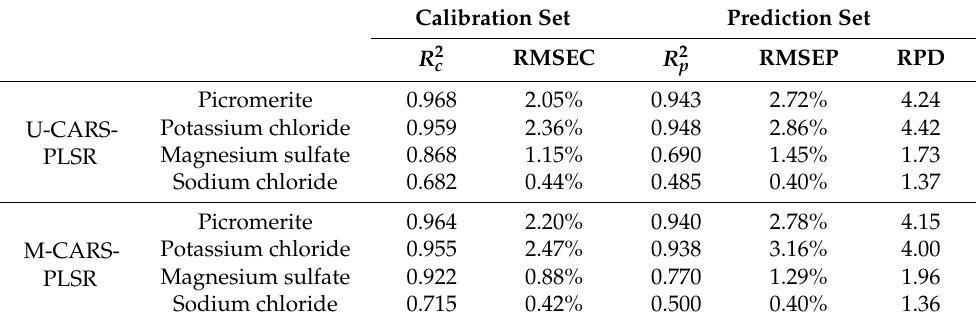
Figure 10. Sensitive wavelengths selected by the CARS method for four minerals in MP samples. Table 7. Results of calibration and prediction sets for U-CARS-PLSR and M-CARS-PLSR